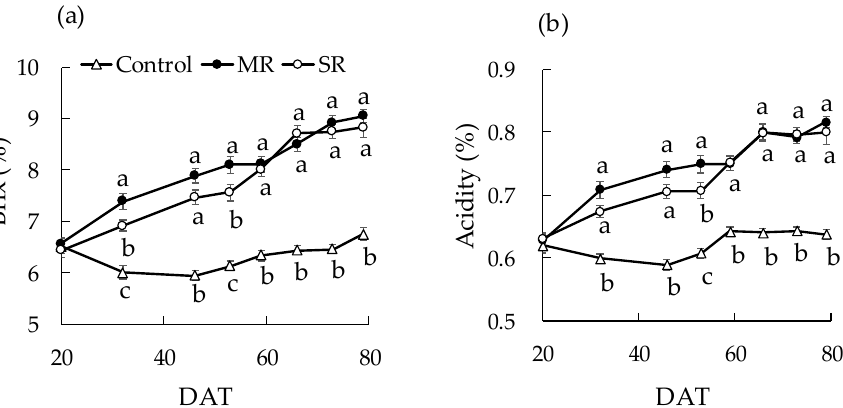
Figure 8. Effects of days of water stress treatment on the Brix ( a ) and acidity ( b ) values of tomato fruits. Fruits were harvested at eight time points (20, 32, 46, 53, 59, 66, 73, and 79 days after commencing treatments (DAT)) throughout the experiment. Each value is shown as the mean ± SE. Different letters indicate significant differences among the treatments, as determined using the Tukey–Kramer’s test at p < 0.05 ( n = 4–6). MR: moderate wilting–full recovery treatment; SR: severe wilting–full recovery